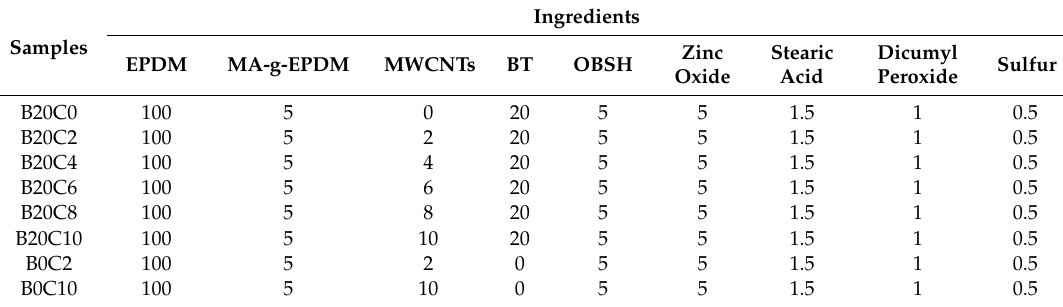
Table 1. Compounds coding and ingredients, in phr (parts per hundred